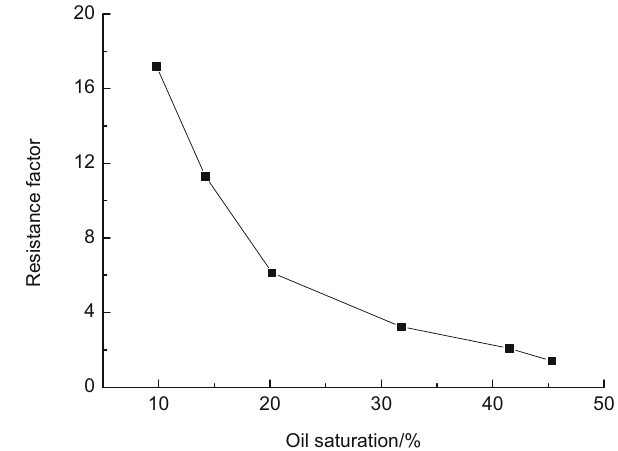
Figure 7: In fl uence of oil saturation on the foam resistance factor.